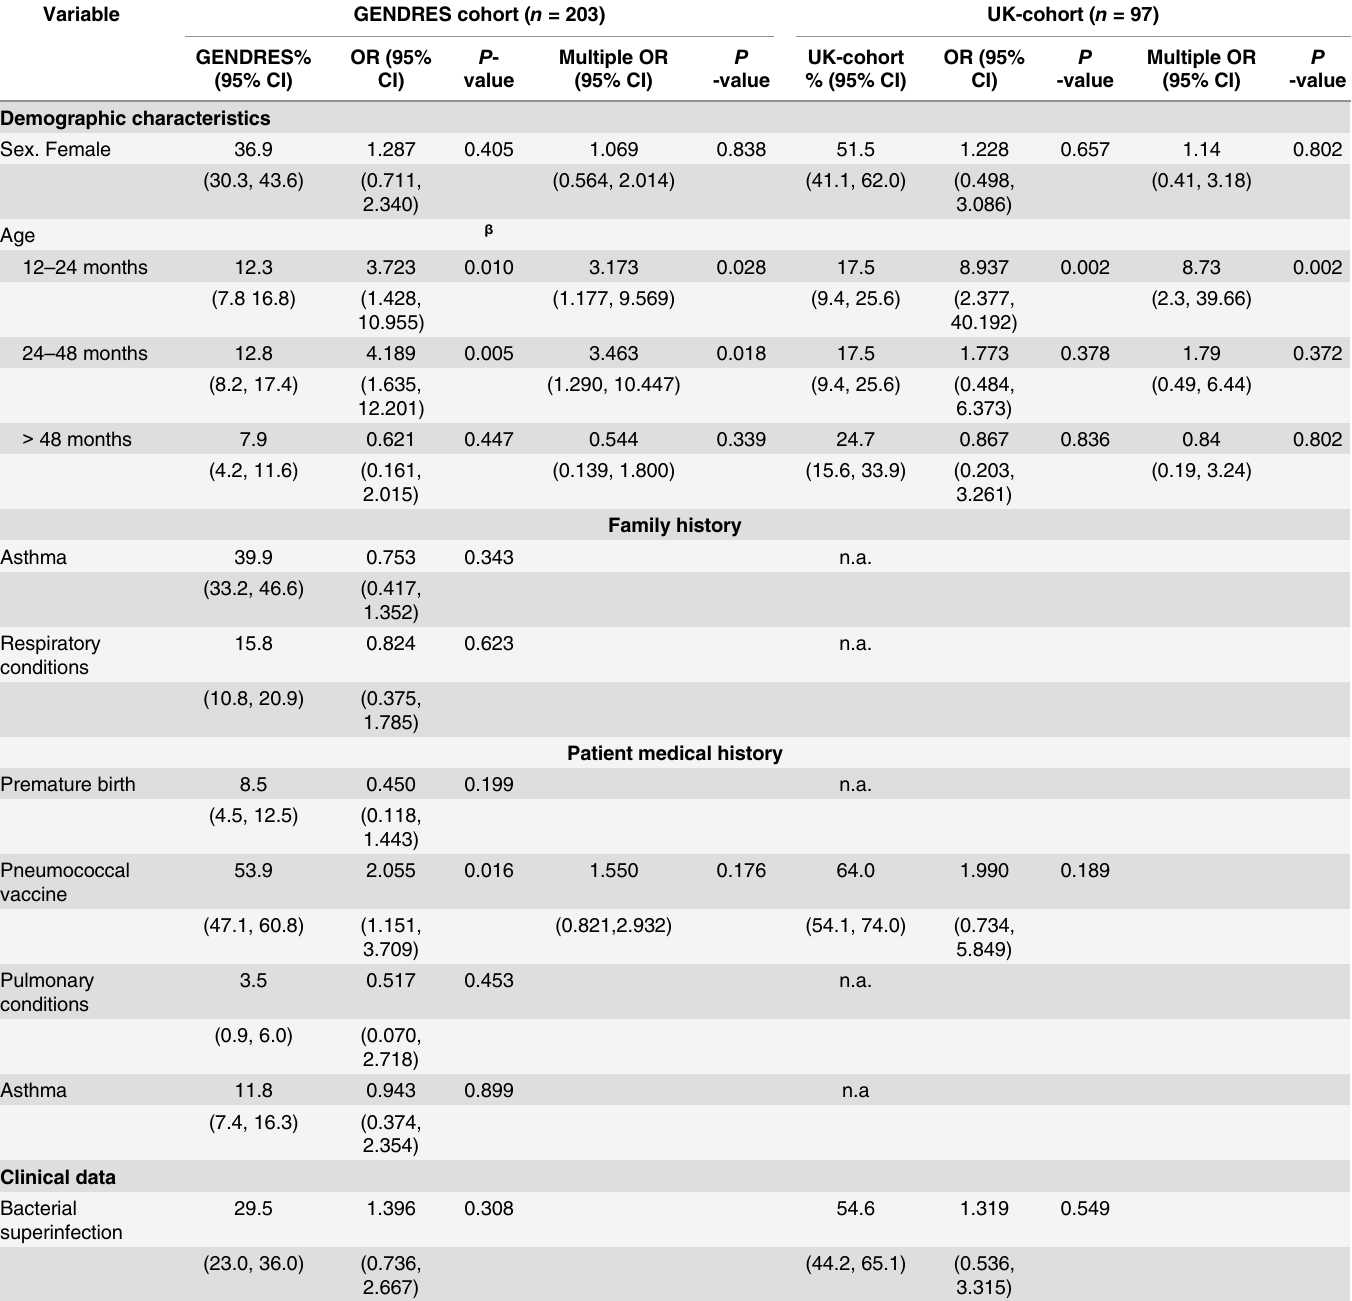
Table 2. Relationship between demographic and clinical variables with mono-infection and co-infection is shown for both GENDRES and UK cohort. The correlation was analysed using simple logistic regression. Data are presented as OR (95% confidence interval) and P -value. The characteristics of the two cohorts analyzed were compared and when P-value results were significant when different: the GENDRES cohort and the UK cohort. P -value results from the comparison between both cohorts. A P -value < 0.005 was considered significant.